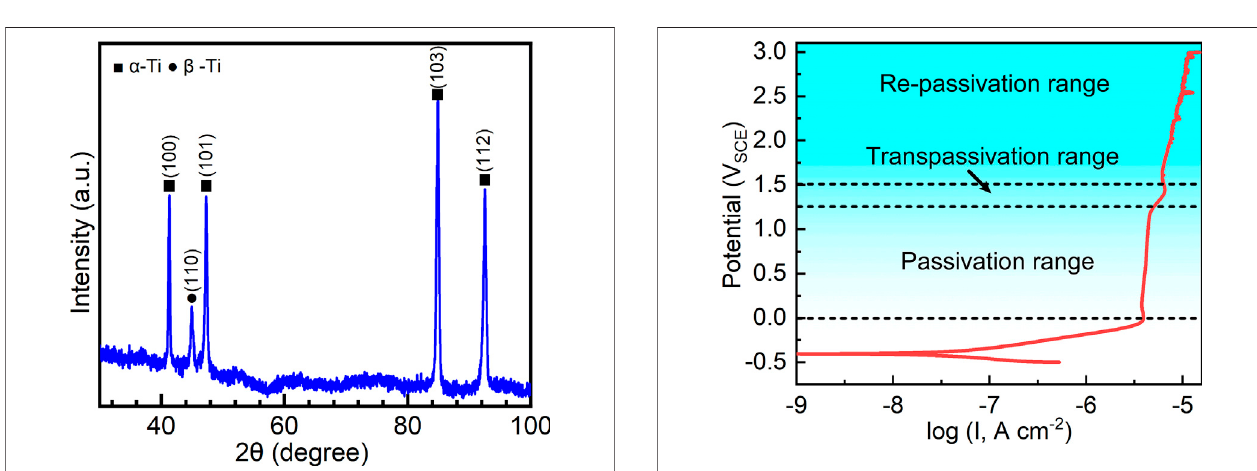
Frontiers in Materials |